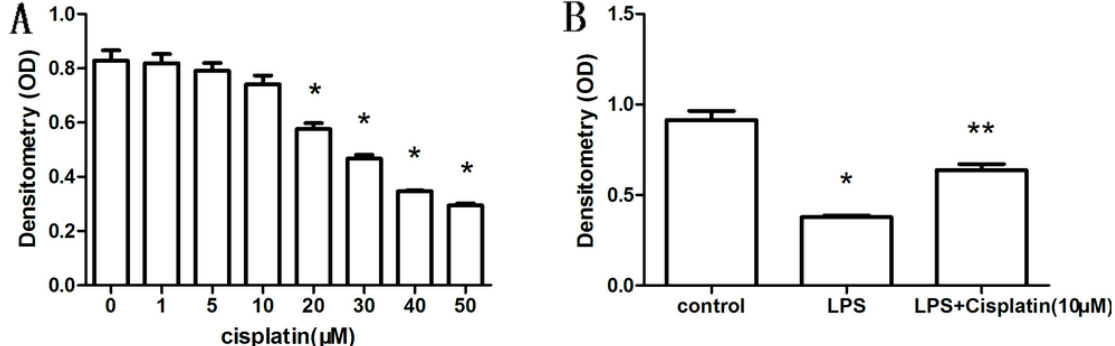
Figure 1. Viability of macrophage-like cells measured by CCK-8 assay. ( A ) Toxic effect of cisplatin (0–50 μ M), relative to medium without cisplatin, * p < 0.05; ( B ) Protective effect of low-dose cisplatin. Cell viability is presented as the densitometry value. A higher densitometryvalue indicates higher viability of macrophage-like cells. Compared to the control group, * p < 0.05; compared to the LPS-treated group, ** p < 0.05. Results are expressed as the mean ± SD ( n = 4).